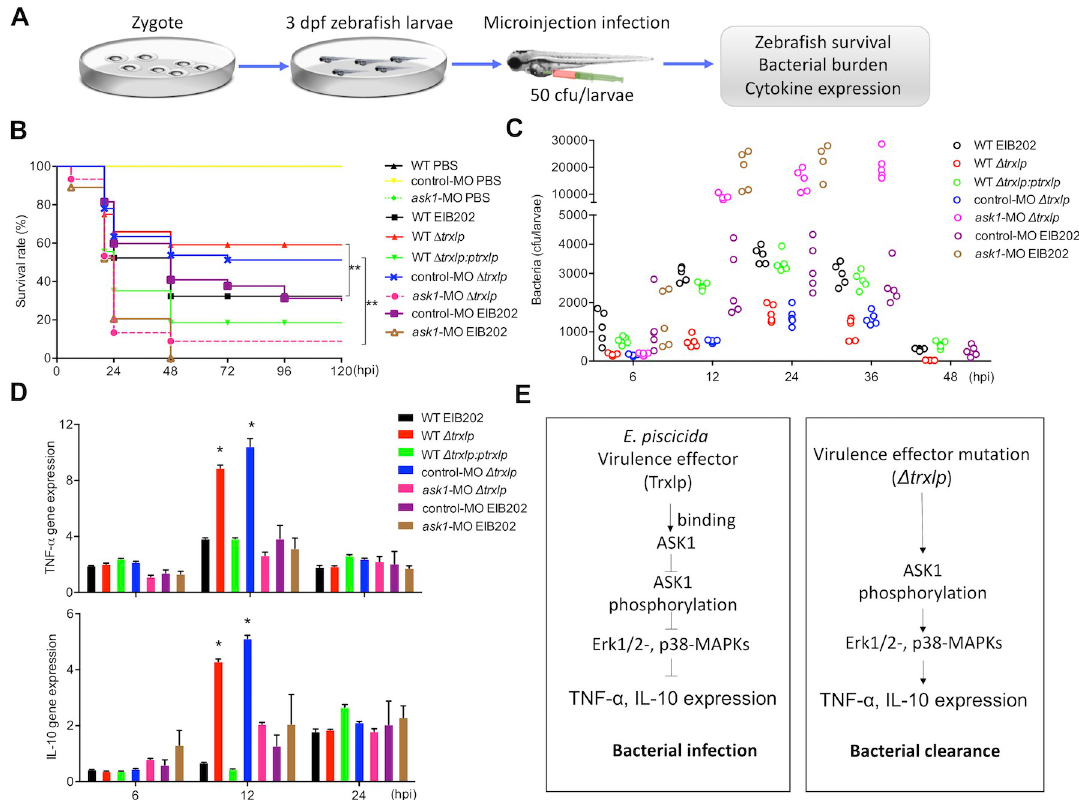
Fig 5. Trxlp promotes bacterial colonization in vivo . (A) Schematic representation of the zebrafish larvae microinjection infection model. Zebrafish larvae were maintained in E3 medium for up to 8 days post-fertilization (dpf). Bacteria were microinjected into the yolk sac of zebrafish larvae at 3 dpf, and the survival, bacterial burden, and cytokine expression were analyzed. (B) Wild-type (WT) or ask1 -MO zebrafish larvae were infected with EIB202, Δ trxlp , trxlp- complemented E . piscicida (50 CFUs/larvae), or PBS as a control, respectively. The survival of zebrafish larvae was monitored for 5 days. n = 50 fish per group. Data shown are from 3 representative experiments. �� p < 0.01. (C) The zebrafish larvae were infected as in Fig 5B and collected at the indicated post-infection time points, and homogenates were plated to determine the bacterial CFUs per larvae. n = 5 fish per group at each time point. Data are representative of at least 3 experiments. ( D) The zebrafish larvae were infected as in Fig 5B, and mRNA levels of TNF- α and IL-10 in indicated zebrafish larvae infected with EIB202, Δ trxlp , or trxlp- complemented E . piscicida at indicated time points were determined by qRT-PCR. PBS-treated zebrafish was used as the control. Data (means ± SD) are representation of 3 experiments. � p < 0.05. (E) Diagram of Trxlp function during E . piscicida infection process. The novel virulence effector Trxlp targets and inhibits the phosphorylation of ASK1, thereby suppressing Erk1/2- and p38-MAPKs and inhibiting the expression of TNF- α and IL-10 during